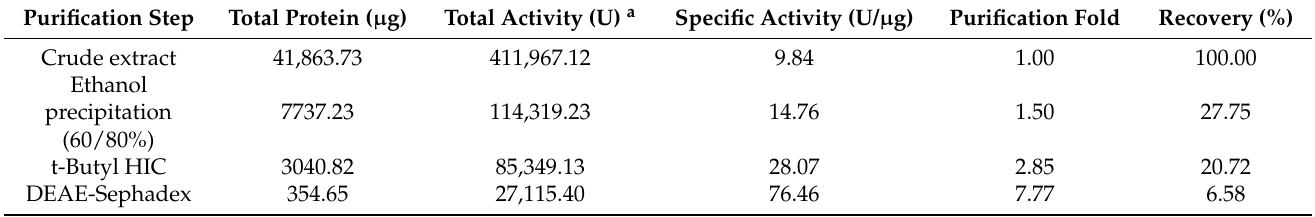
Figure 2. Purification of the fibrinolytic enzyme (Velefibrinase) from B. velezensis Z01. ( a ) Purification of Velefibrinase from B. velezensis strain Z01 by DEAE-Sephadex chromatography. The eluted proteins were monitored at 280 nm. The arrow indicates eluted Velefibrinase. ( b ) Determination of the purity and molecular mass of Velefibrinase using 12% SDS-PAGE. Lane M, protein molecular mass markers; Lane 1, ammonium sulphate precipitated proteins; Lane 2, HIC-II fraction; Lane 3, D-3 fraction. ( c ) The circular dichroism (CD) spectrum of natural Velefibrinase in 0.1 M PBS (pH 7.2). Table 1. Steps of the purification process of Velefibrinase from B. velezensis Z01